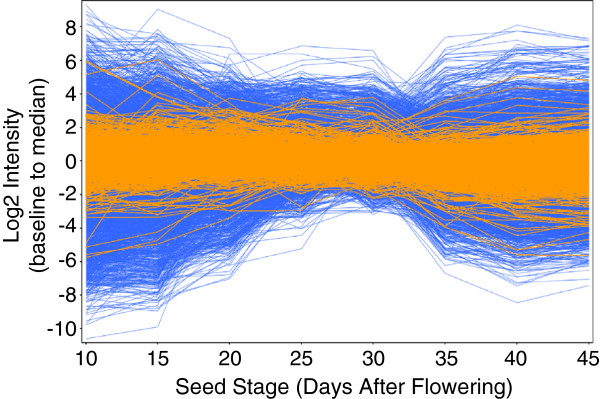
Overview of gene expression during seed development (in blue). The predicted miRNA targets are highlighted in orange. Each line represents one unigene. The Y-axis shows the normalized signal intensity (with baseline transformation to the median of all samples).